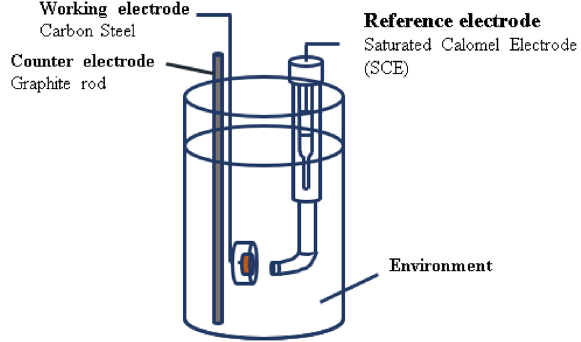
Figure 5. Three-electrode setup for collecting data.